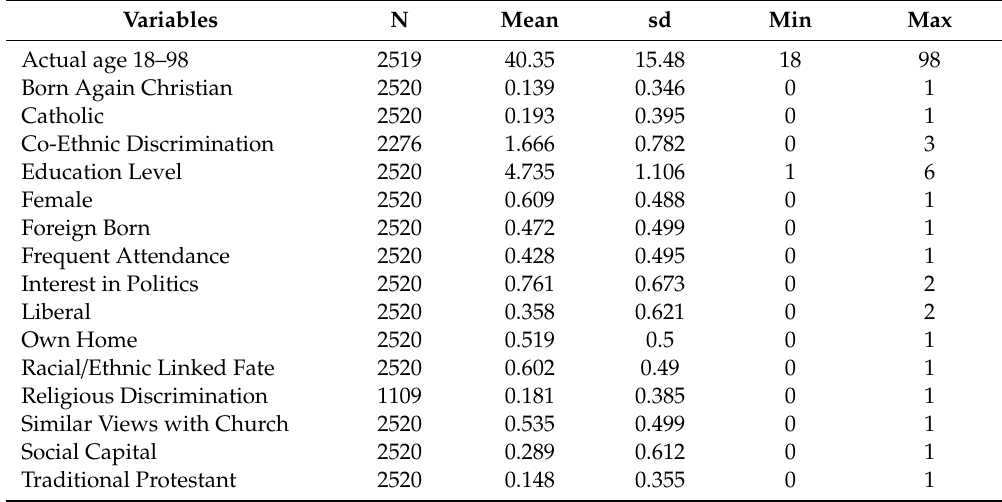
Tables 1–3: Summary Statistics for Asian, Black, and Latino Respondents. Table 1. Asian respondents’ summary